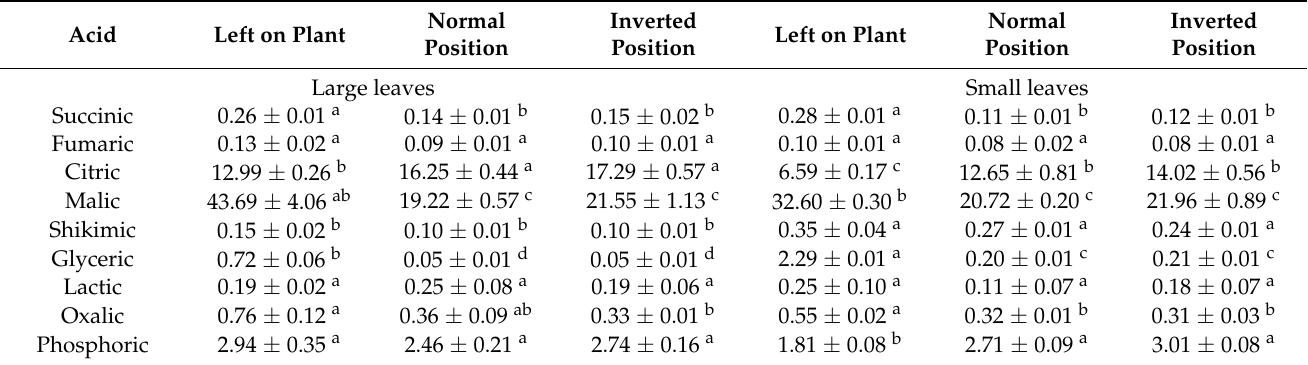
Table 4. Acid content (mg/g DW) of K. blossfeldiana leaves on the plant, and in leaves detached from the plant and kept for 4 days in the normal (natural) position or kept for 4 days in the inverted position. Mean results in rows ± standard deviation followed by the same letter were not significantly different ( p < 0.05) according to Tukey’s test.